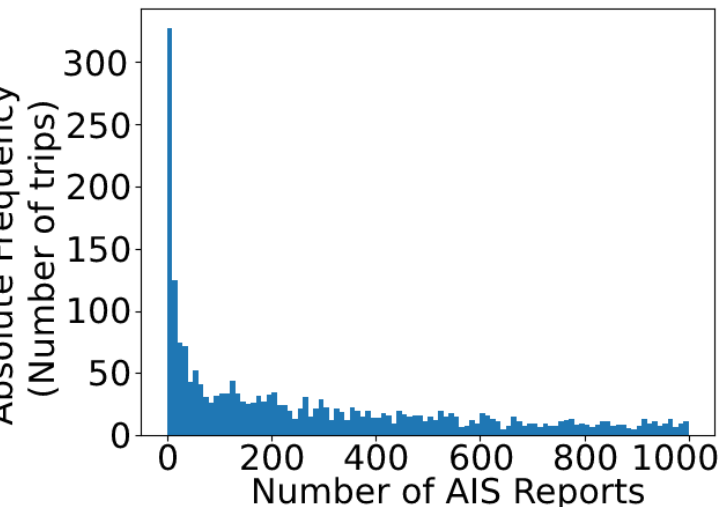
Figure 5. Number of AIS messages per found trip in the month of June 2018, along the southern coast of Portugal.